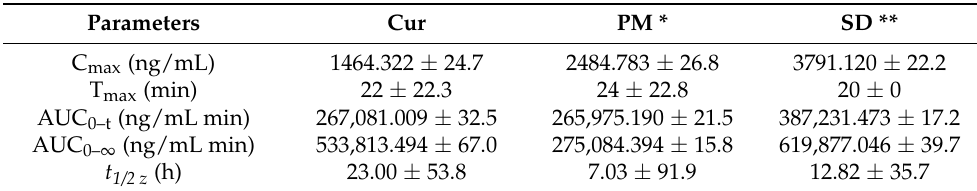
Table 3. The pharmacokinetic parameters of raw Cur, PM and the SD in rats after oral administration (n = 5, mean ± RSD).